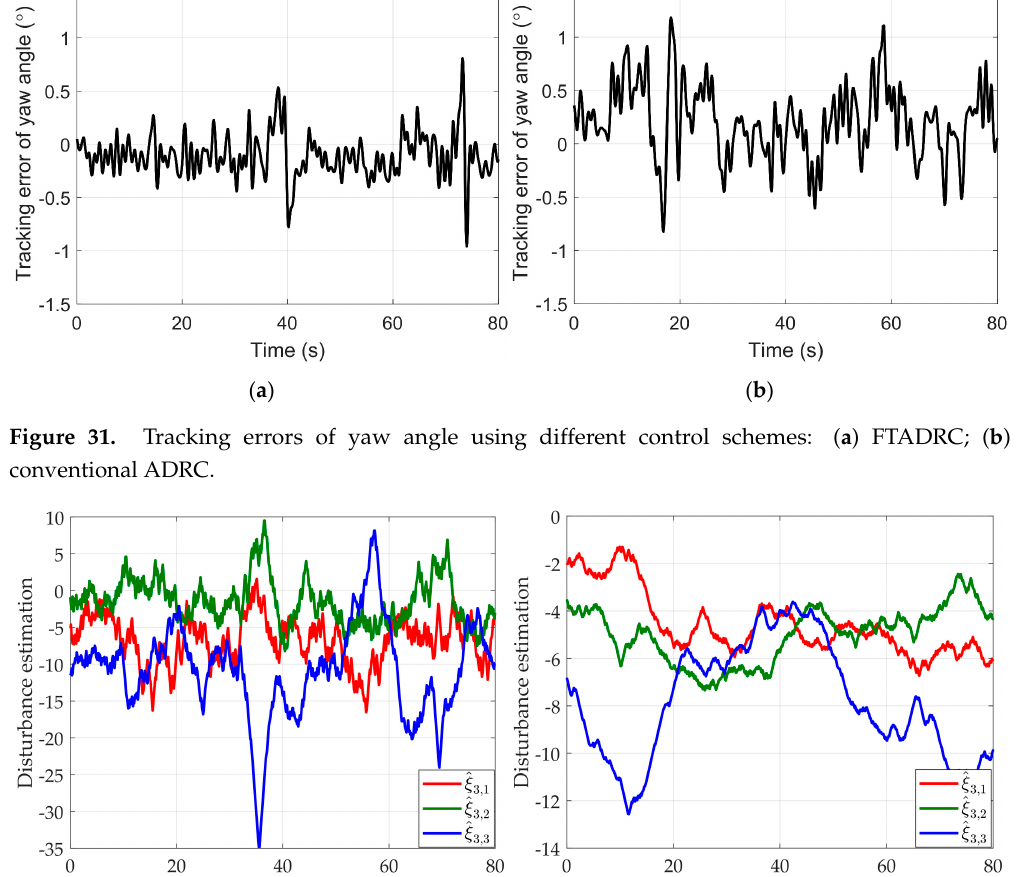
Figure 30. Tracking errors of pitch angle using different control schemes: ( a ) FTADRC; ( b ) conventional ADRC.